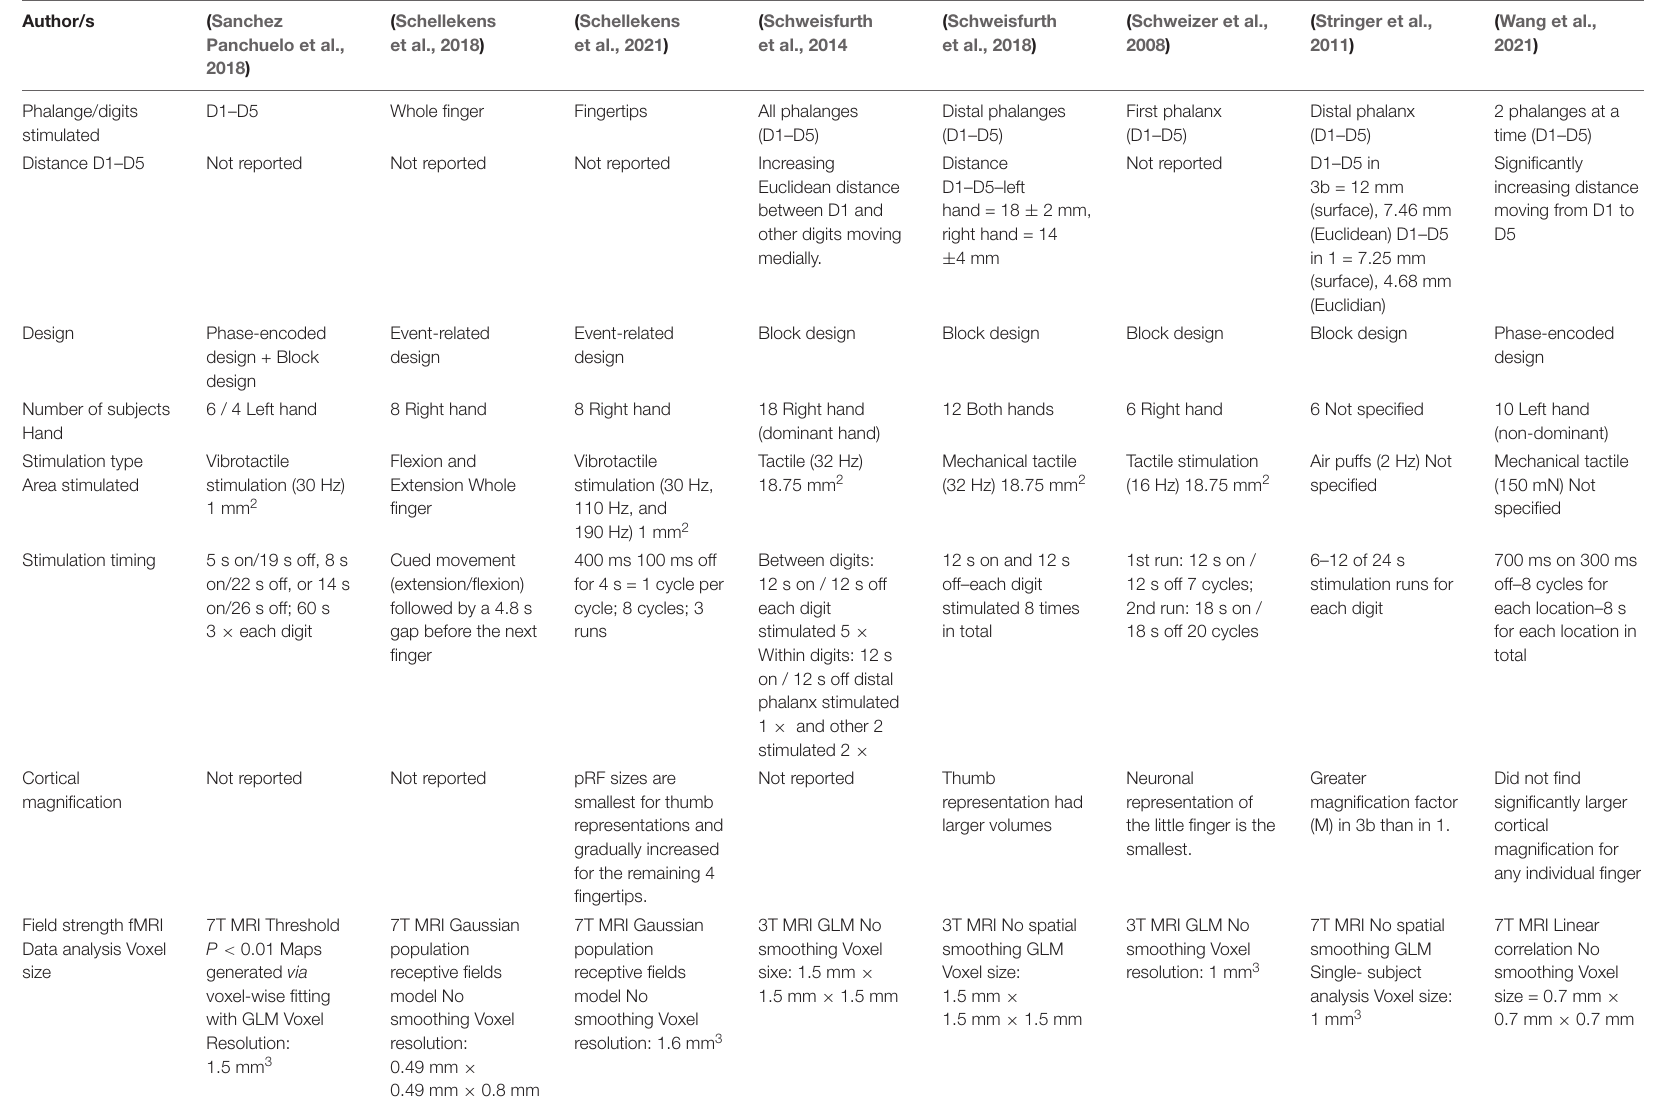
TABLE 2 | Overview of fMRI